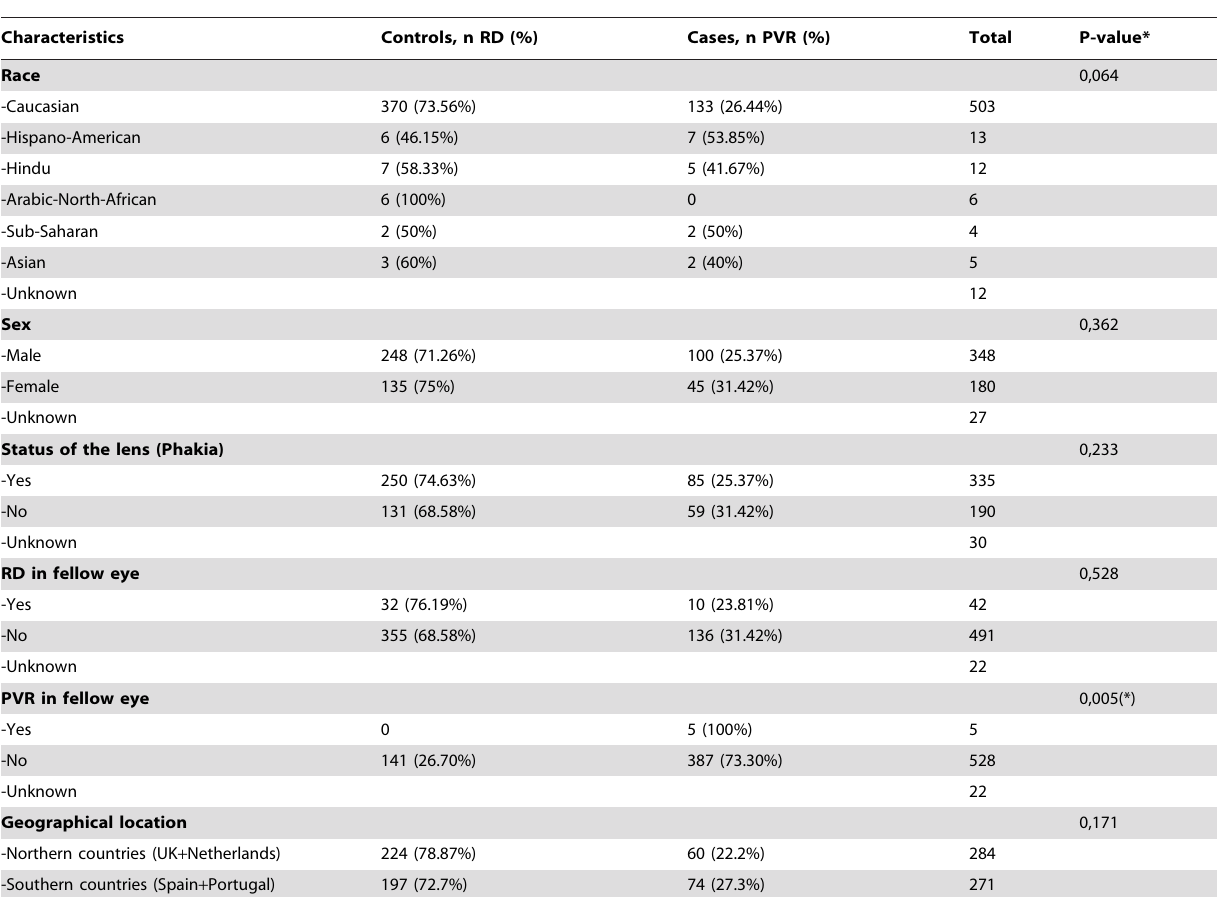
Table 1. Clinical characteristics of the whole sample.